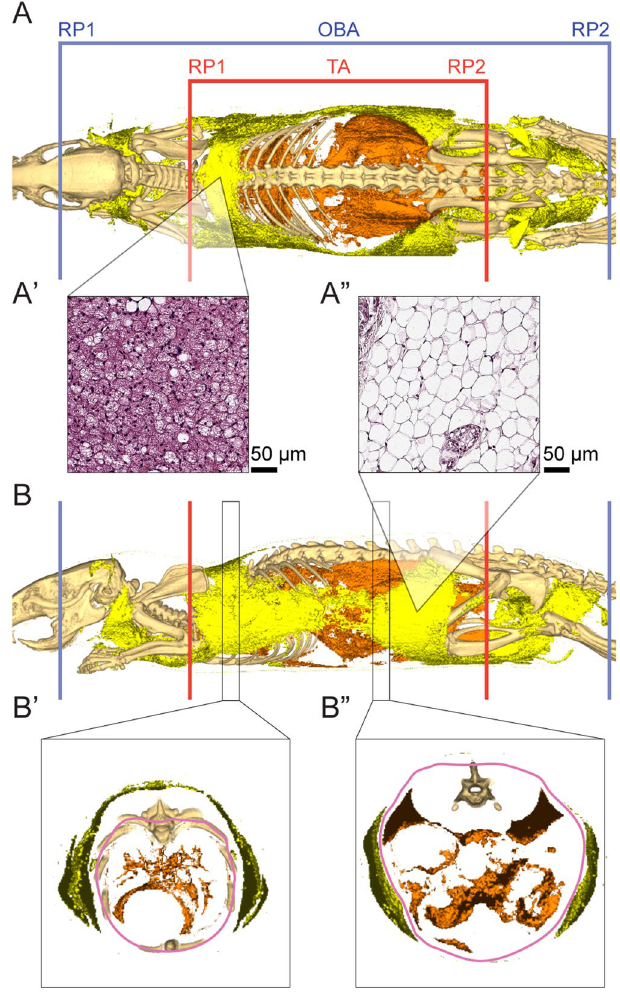
Figure 2. Reference points of the image analysis. ( A ) Dorsal view of a scanned rat. The thoracoabdominal region was comprised by the reference points TA RP1 and TA RP2 (red lines). The OBA region is delimited between the posterior boundary of the olfactory bulb and the anus, by the reference points OBA RP1 and OBA RP2 (blue lines) The VAT is represented in orange, and the SAT in yellow. ( A’ and A” ) Histological view of